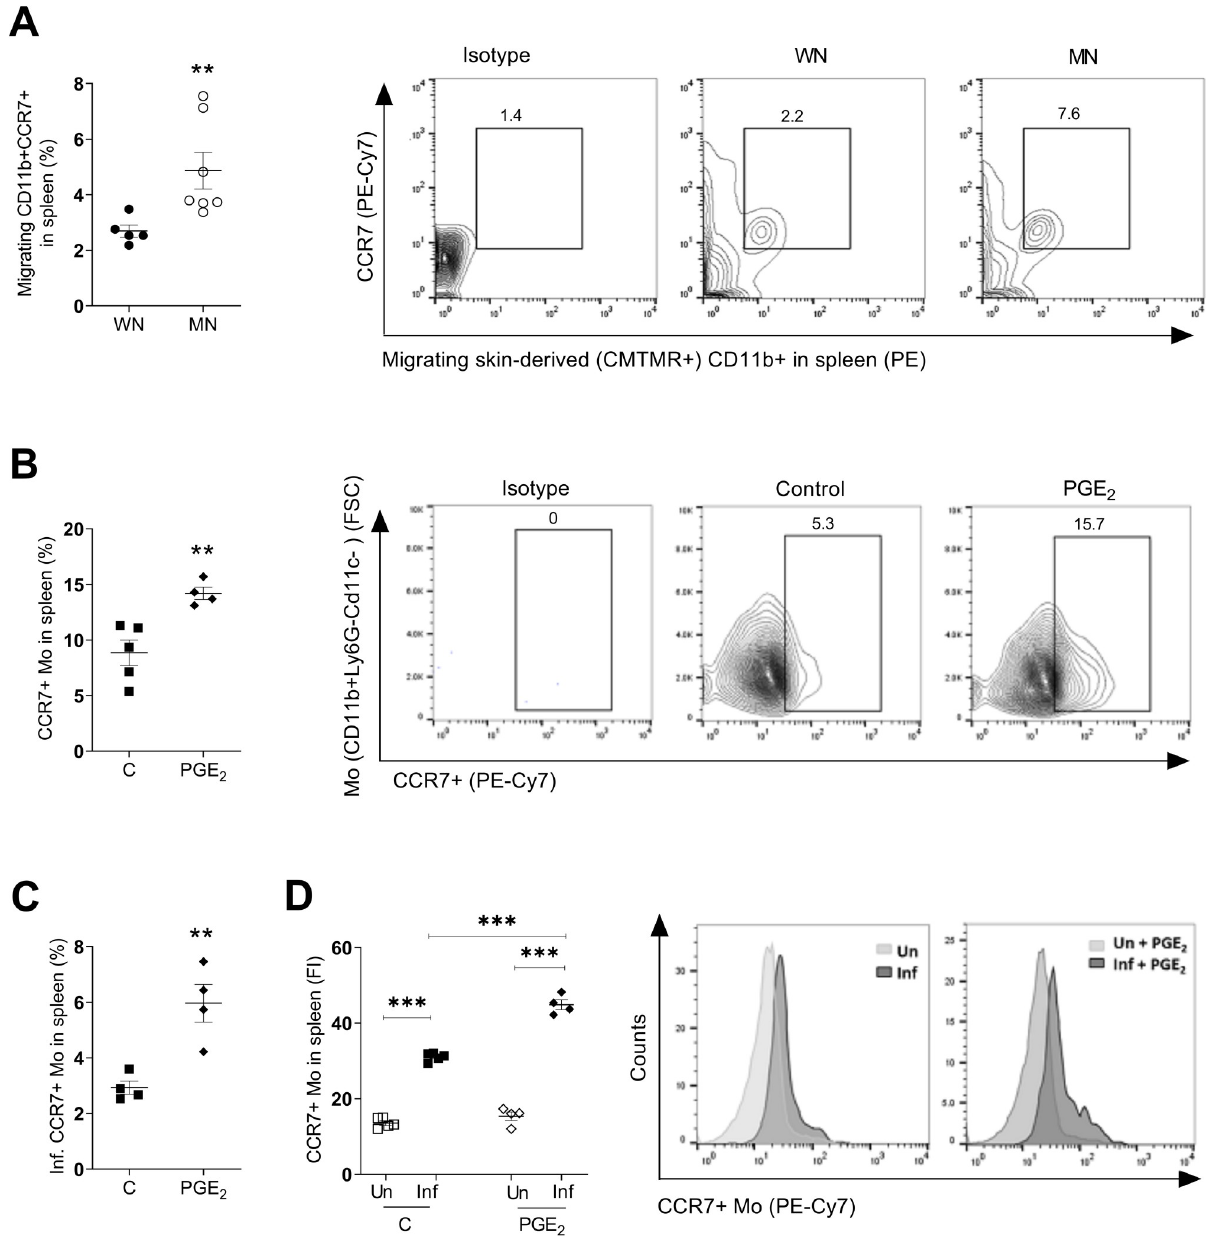
Fig 5. Malnutrition-related increase in CCR7+ skin-derived monocytes in the spleen of mice following intradermal L . donovani infection is amplified by PGE 2 . A. Percent of CCR7+ CD11b+ cells trafficking from skin (skin-derived CMTMR+) relative to total CD11b+ cells in the spleen of well-nourished (WN) or malnourished (MN) mice at 72h after ID infection and skin painting with CMTMR. Shown as a graph (N = 5–7 mice per group) and representative contour plot. �� p = 0.02 (Unpaired t-test). B. Percent of CCR7+ monocytes relative to total monocytes in the spleen of control (C; DMSO-treated) and PGE 2 -treated mice. Determined by flow cytometry at 48 hrs p.i. Shown as a graph (4–5 mice per group) and representative contour plot. �� p = 0.006 (Unpaired t-test). N = 4 mice per group. C. Percent of infected CCR7+ monocytes relative to total monocytes in spleen of control (C; DMSO-treated) and PGE 2 -treated mice at 48 hrs after ID infection. �� p = 0.005 (Unpaired t-test). N = 4 mice per group. D. Intensity of CCR7 expression in monocytes without parasites (Un) or containing parasites (Inf) in spleen of control (C) and PGE 2 -treated mice 48 hrs after ID infection with PKH-26 labeled L . donovani . ��� p < 0.0001 (One-way Anova). Shown as a graph (N = 4 mice per group) and representative histogram of 2 independent experiments.